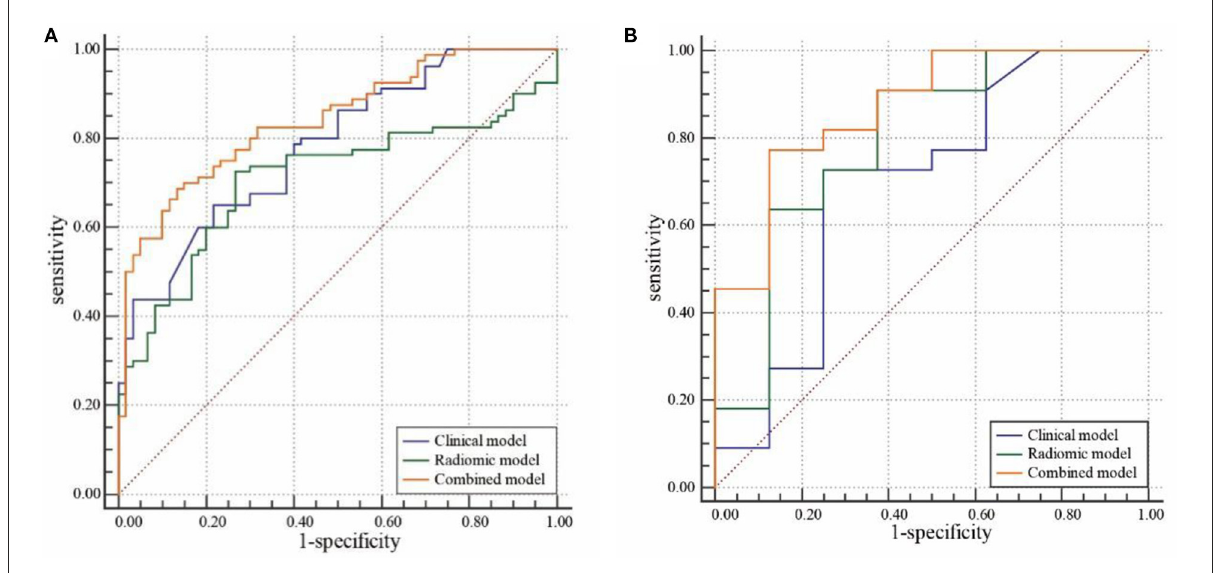
FIGURE3 Receiver operating characteristic (ROC) curve analysis of the clinical, radiomic, and combined models in the training cohort (A) and validation cohort (B) .